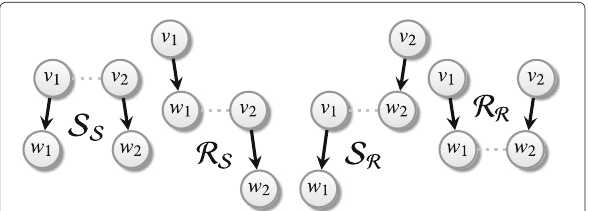
= ( 0,1 ) , K 0 ( 1 ) = 0, K 1